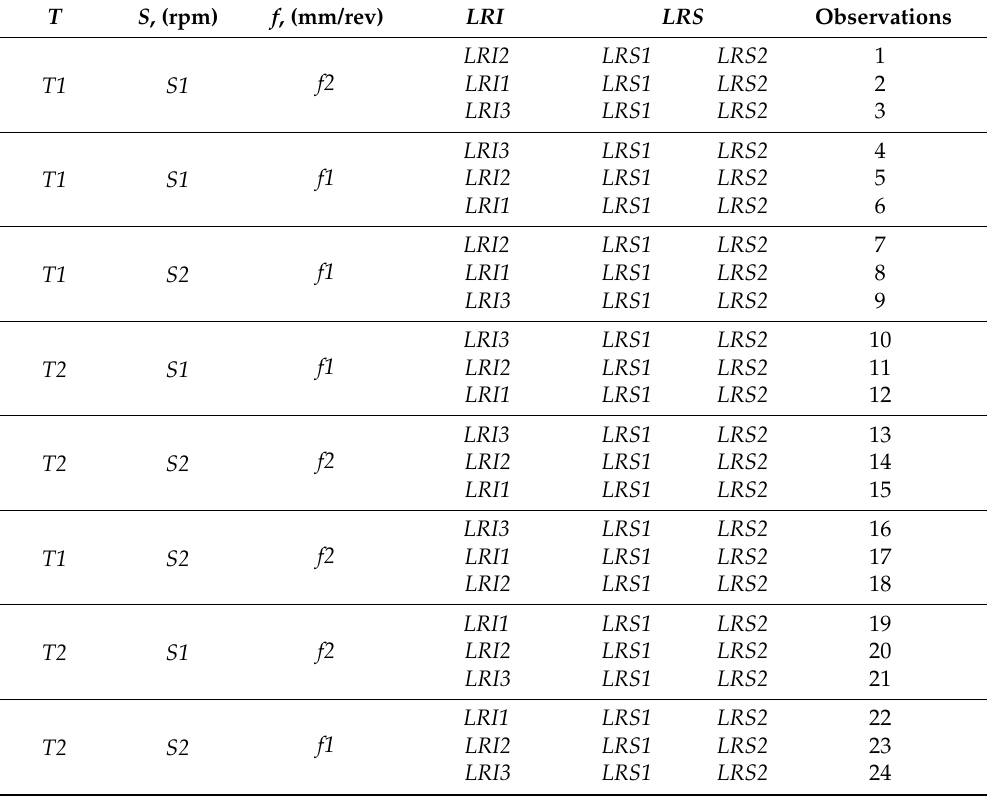
Table 2. Randomized experimental design product of a full factorial 2 3 and a block of two factors 3 × 2.